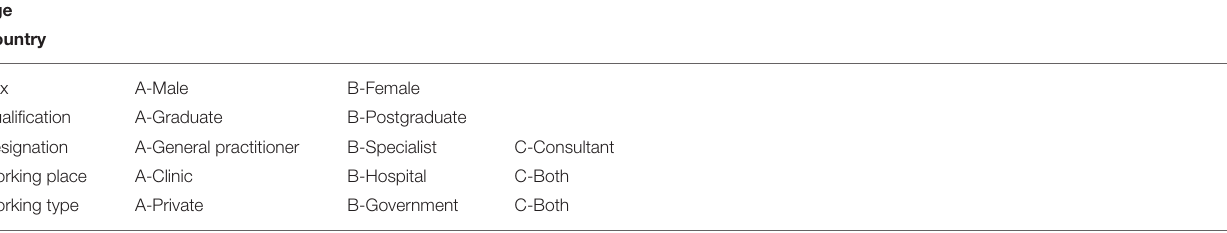
TABLE 1 | The study questionnaire.